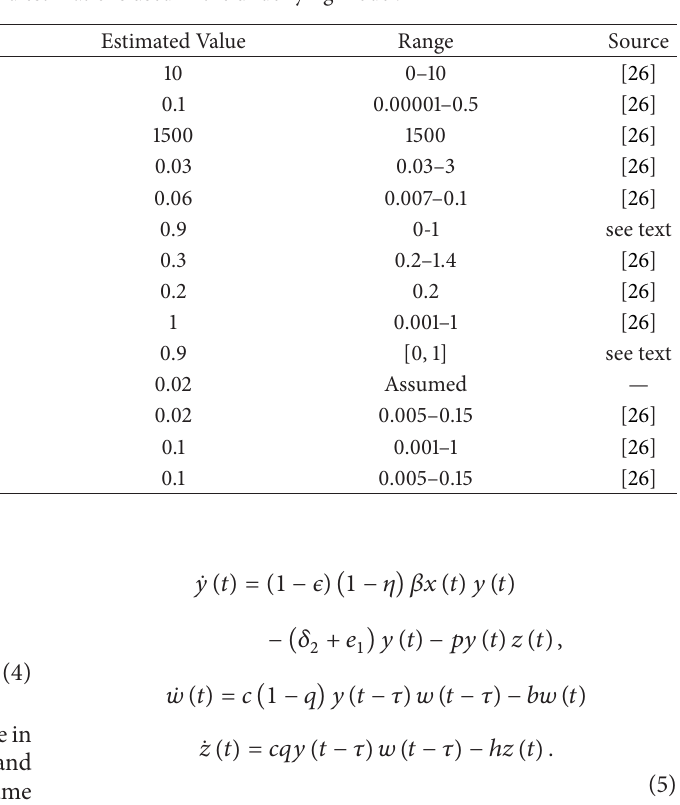
Table 1: Parameter definitions and estimations used in the underlying